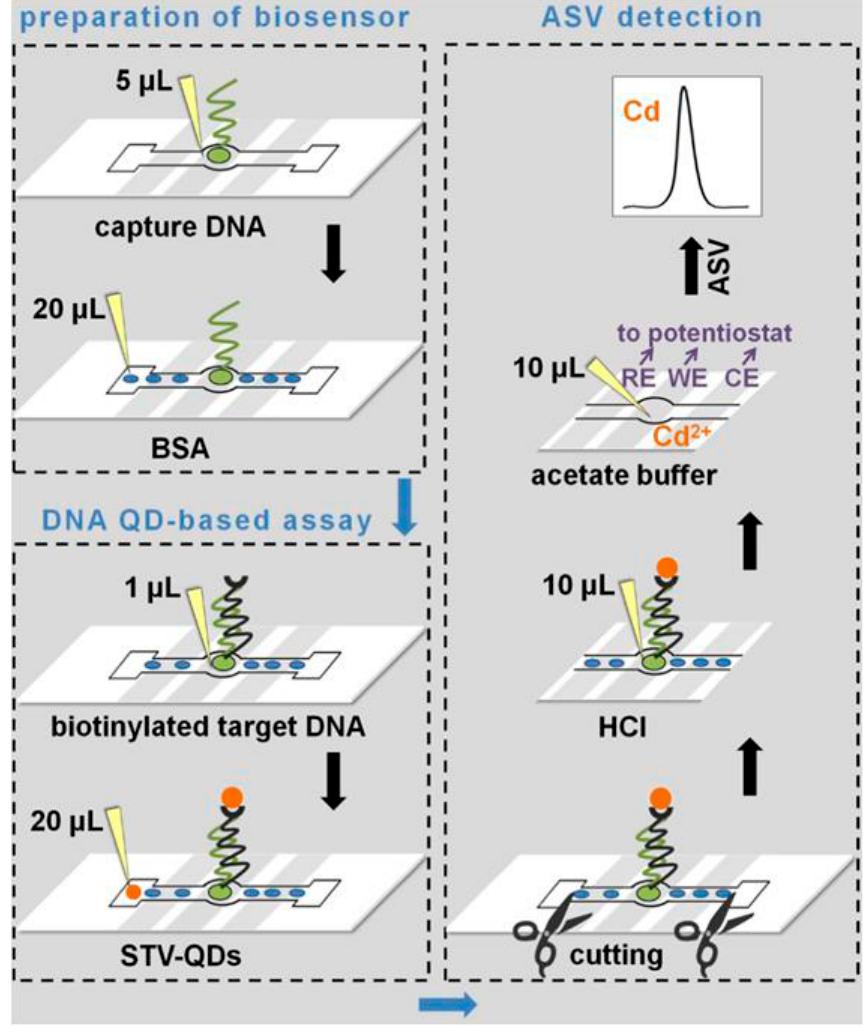
Figure 10. Schematic illustration of the development of paper-based DNA biosensor fabricated through wax-printing and sputtering. Reproduced from [63], with permission from American Chemical Society, 2019.